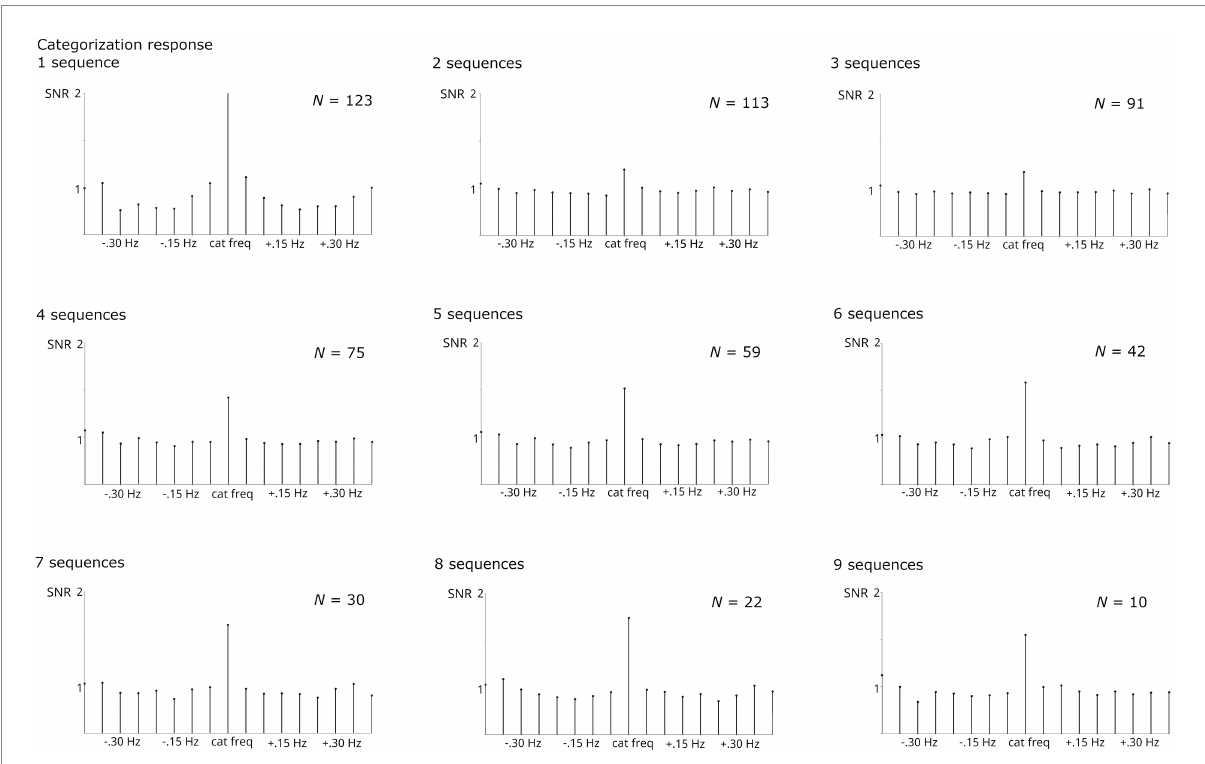
FIGURE 5 SNR of grand-average categorization responses summed across harmonics 1–19 and compared across numbers of sequences averaged. The respective N contributing to each analysis is specified per graph. Highly significant categorization responses were obtained in all